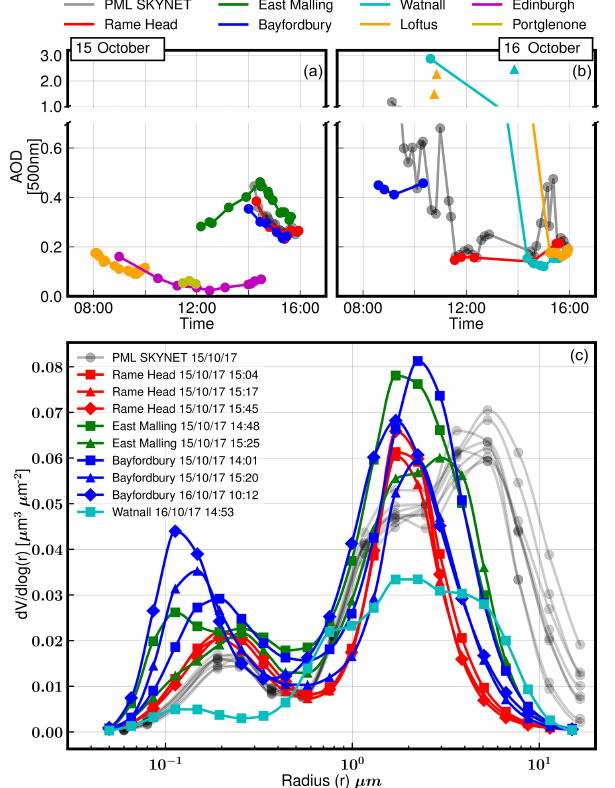
Figure 9. UK AERONET and SKYNET AODs and volume size distributions for 15 and 16 October 2018. Please note the break in the y axis in (a) and (b) showing AOD. AODs are at 500nm. AERONET data are level 2.0 (v3), except for the AOD values plot- ted with triangles – these data are level 1.0 (v3) and are not cloud screened (please see text for explanation).